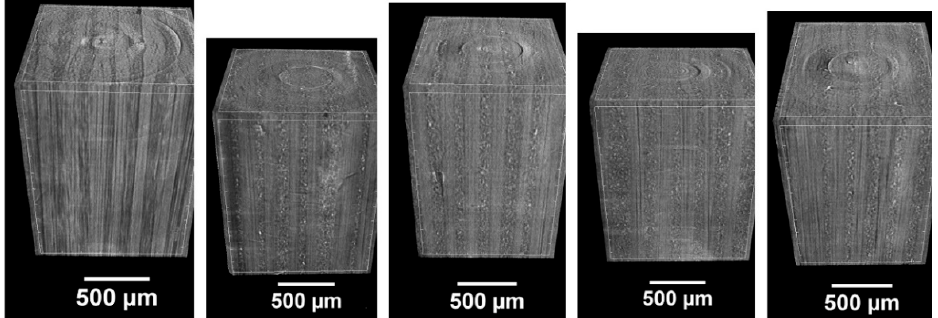
Figure 8. µ CT scans of prepreg laminates, from left to right: unfilled, 10, 15, 20 vol% of large particles, 15 vol% of small particles.